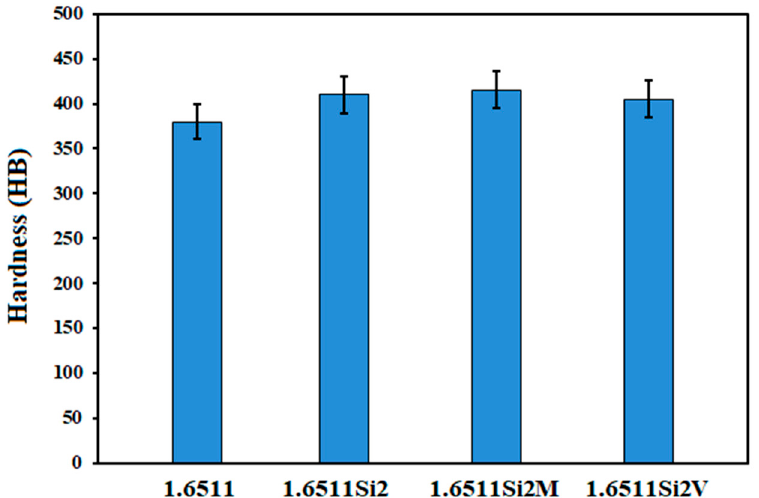
Figure 11. Variation in the hardness of the samples based on their identification codes.